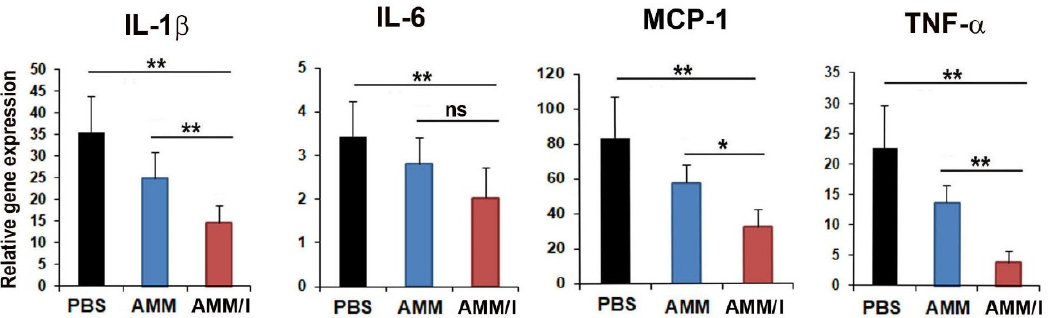
Figure 5. AMM/I transplantation suppresses the inflammation of mouse joints. Quantitative reverse transcription-polymerase chain reaction (qRT-PCR) analyses of joint tissues injected with phosphate-buffered saline (PBS), AMMs, and AMM/I. AMM/I transplantation resulted in decreased expression levels of representative pro-inflammatory factors and increased expression levels of anti-inflammatory factors. (n = 5 each; * p < 0.05, ** p < 0.01). ns, not significant.